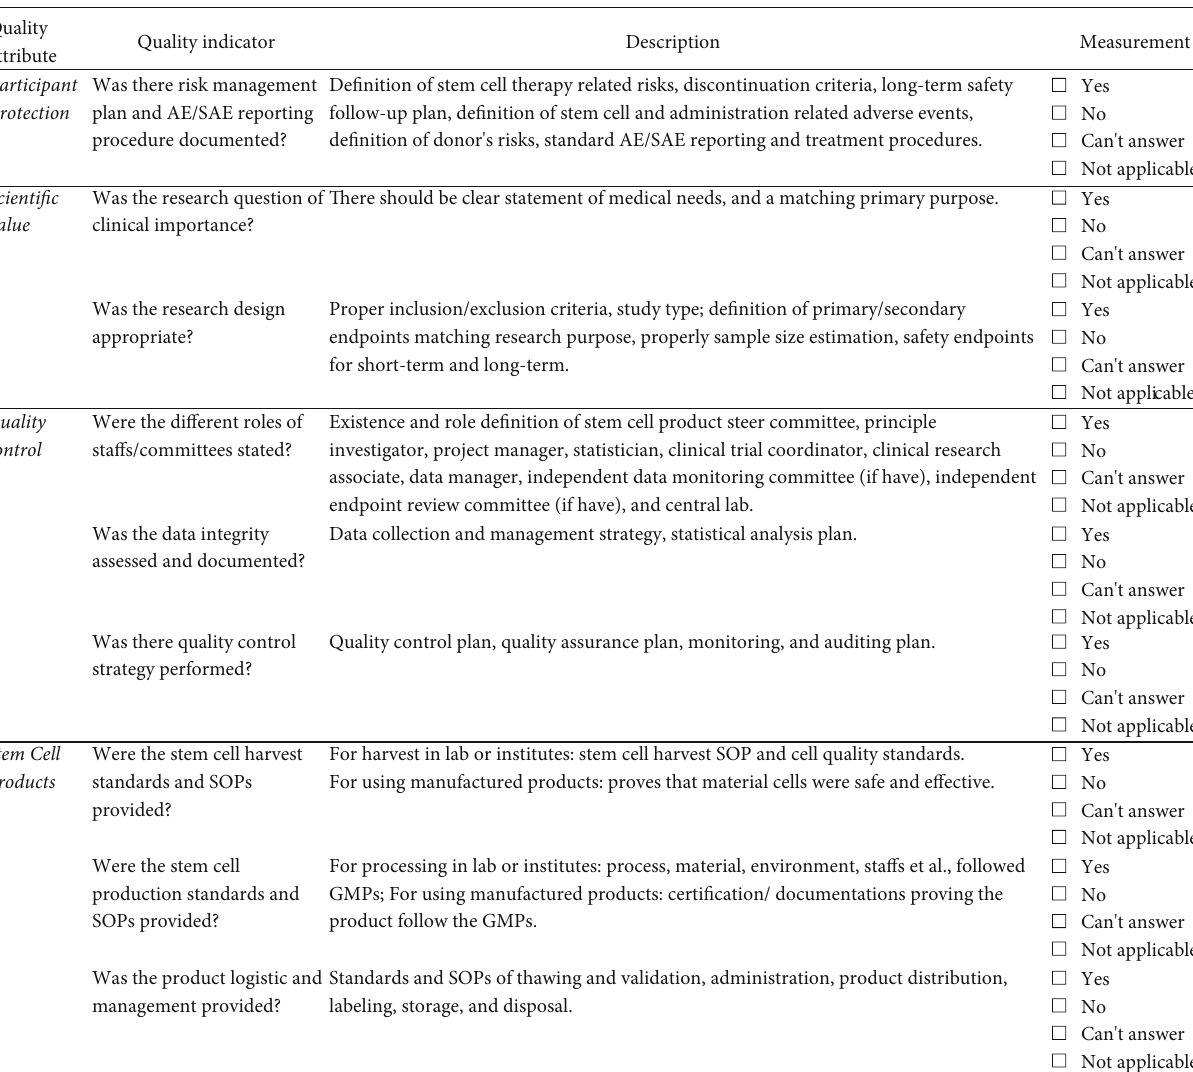
Figure 2: Framework of attribute and indicators of quality assessment tool for stem cell clinical trials. AE: adverse event; SAE: severe adverse event; SOP: standard operation procedure; GMP: Good Manufacture